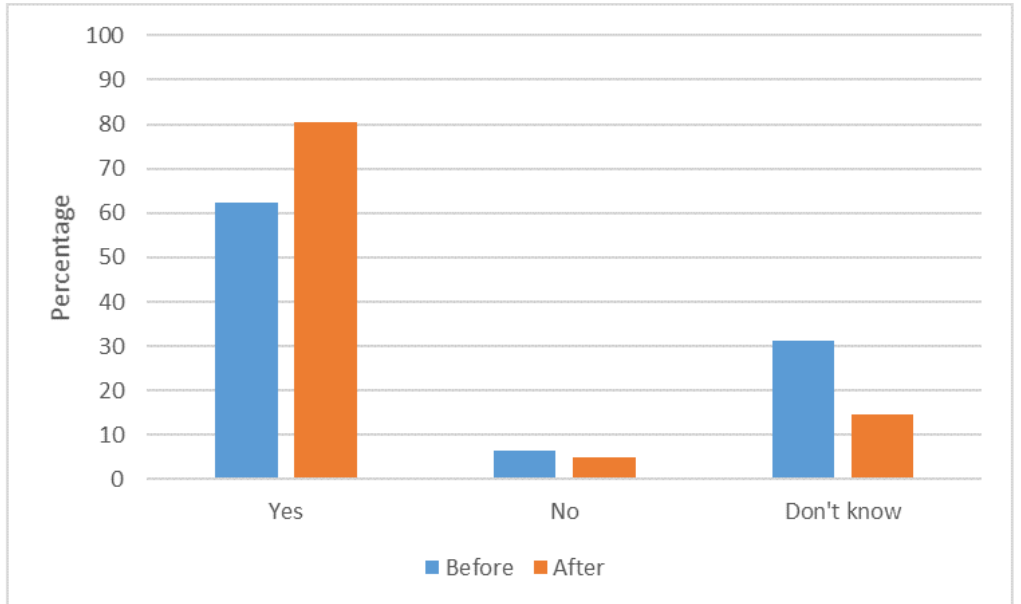
Figure 3. Public views on willingness to use mobile phone data for research before and after the